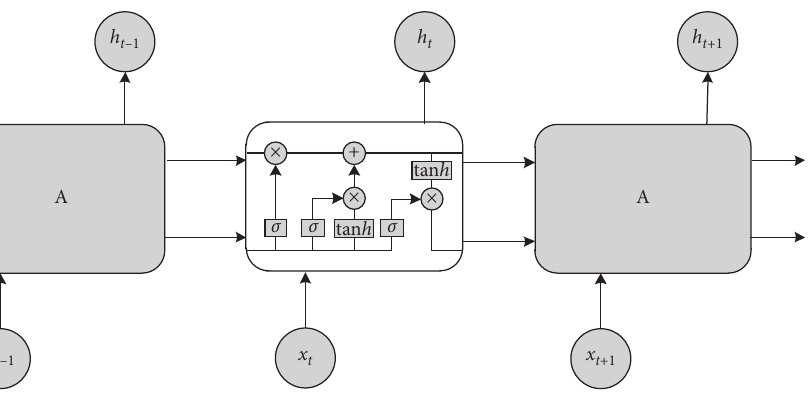
Figure 2: Structure of